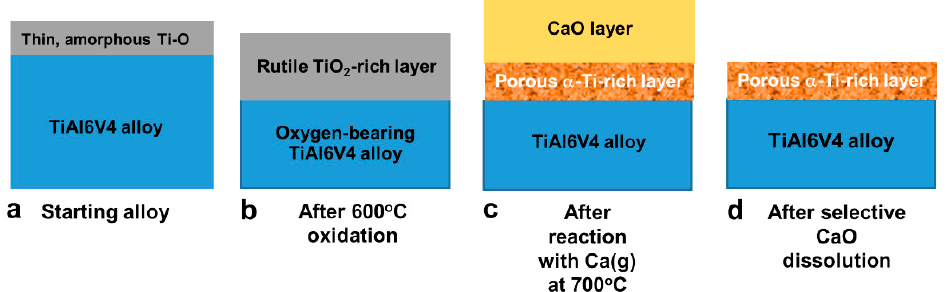
Figure 1. Schematic illustrations of the chemical, phase, and structural evolution associated with the non-line-of-sight reaction process: ( a ) starting TiAl6V4 alloy, ( b ) after surface oxidation in air at 600 °C for 6 h, ( c ) after reaction with Ca(g) at 700 °C for 1 h, ( d ) after selective CaO dissolution in acetic acid.